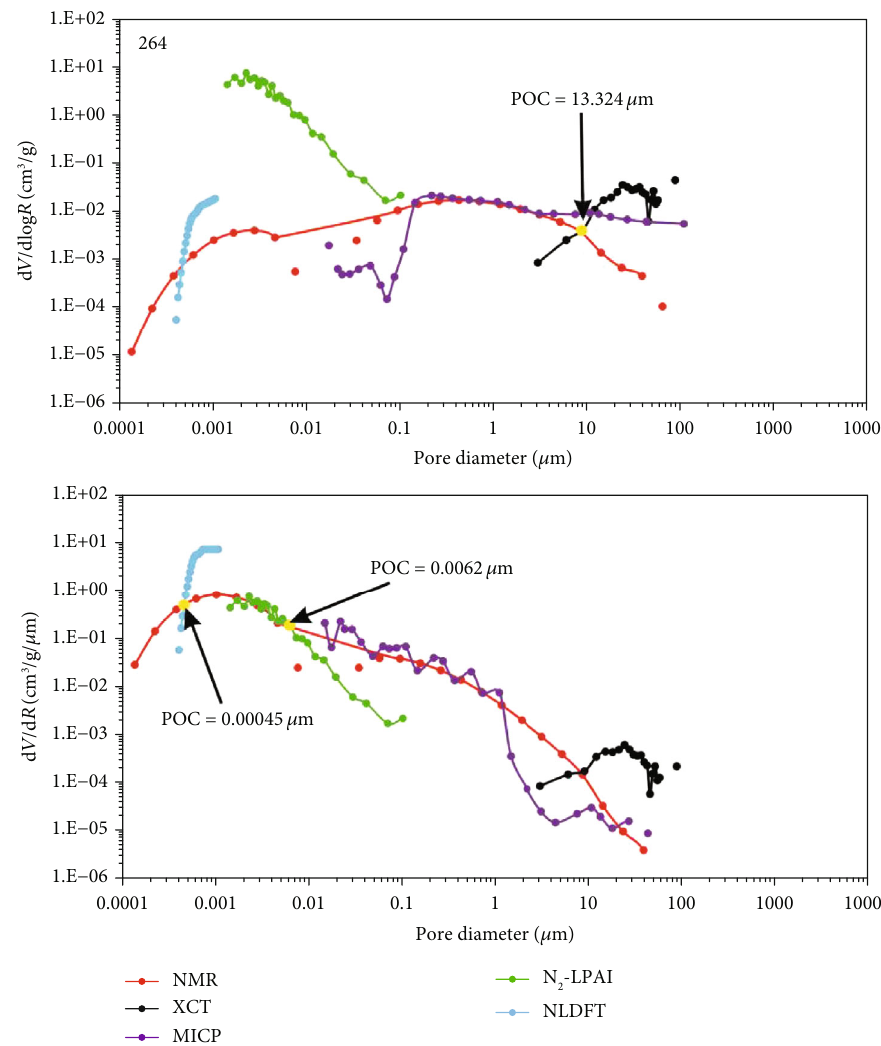
Figure 13: Determination of POC in terms of the d V /d R and d V /dlog R curves from sample